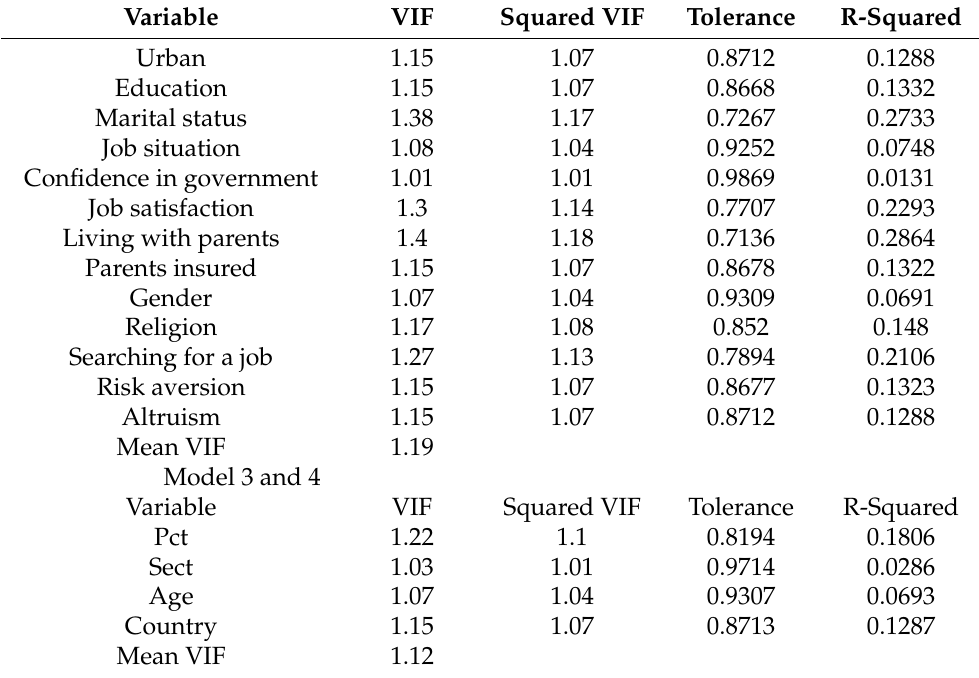
Table 4. Collinearity diagnostic. Source: Sahwa